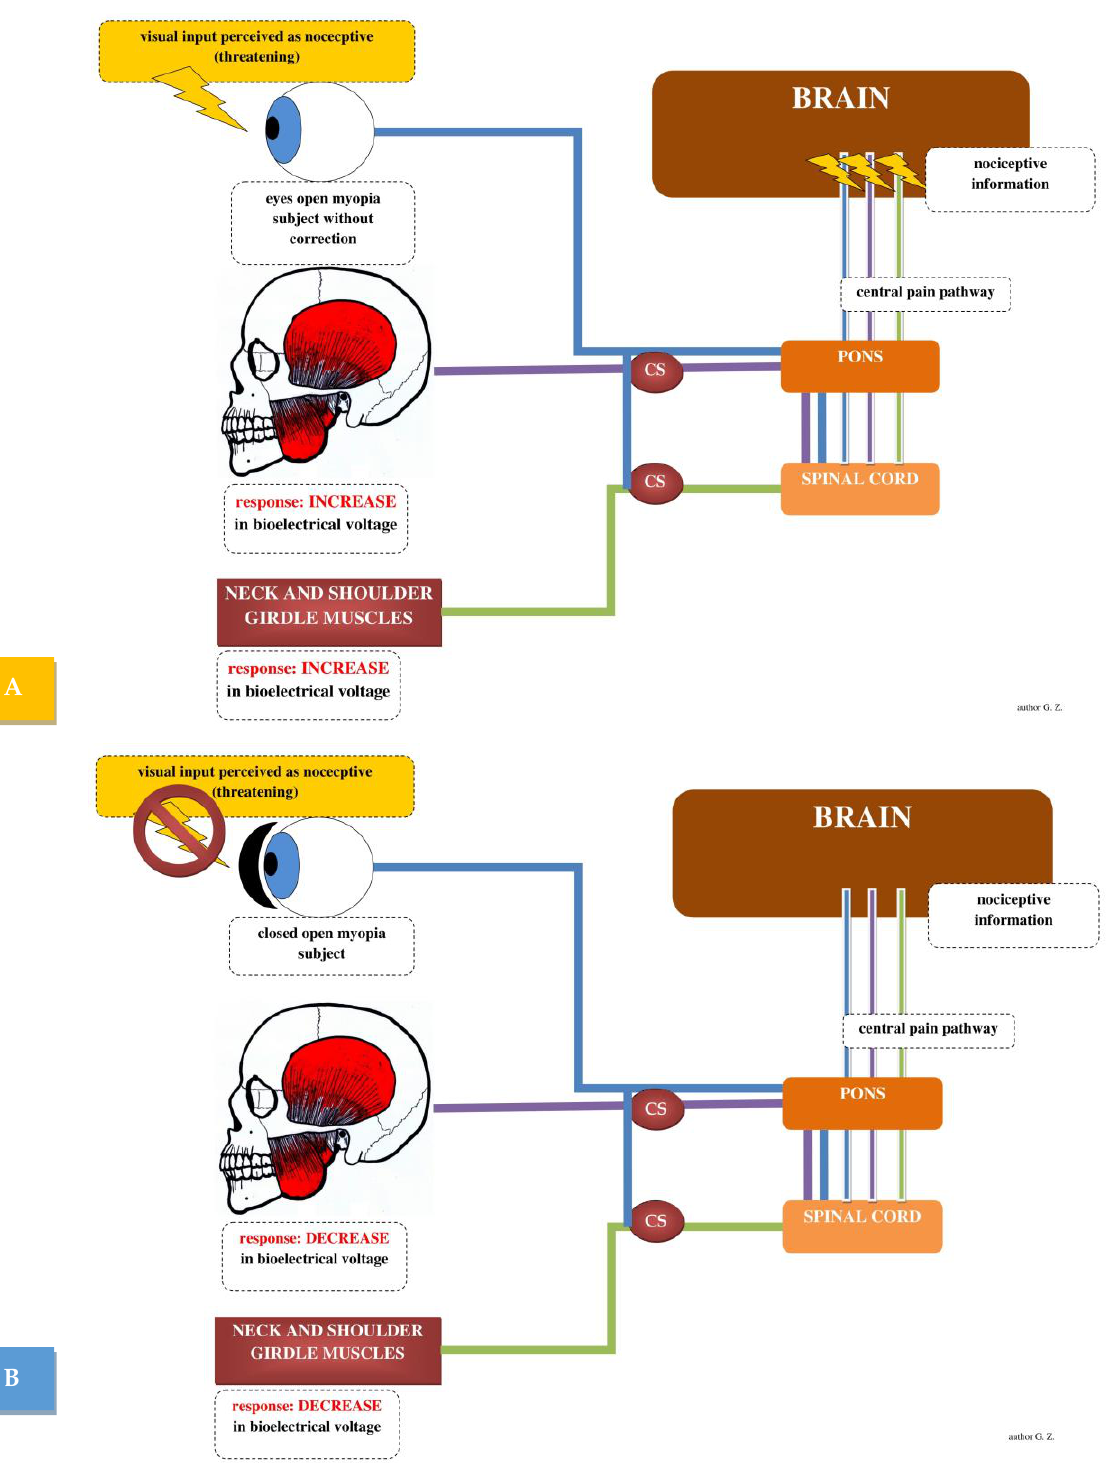
Figure 2. Changes in muscle activity associated with central sensitization (eyes open—( A ) and eyes closed—( B )) in myopic subjects.